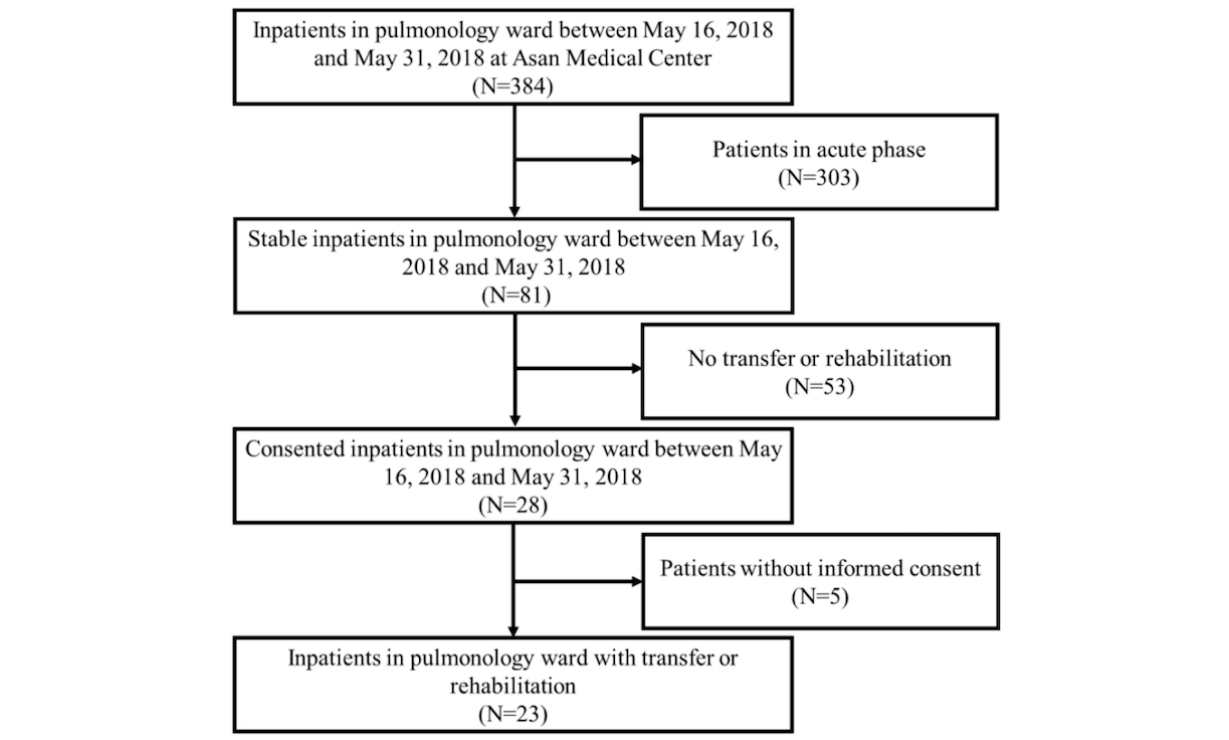
Figure 2. Recruitment for patient safety study related to patient transfer within